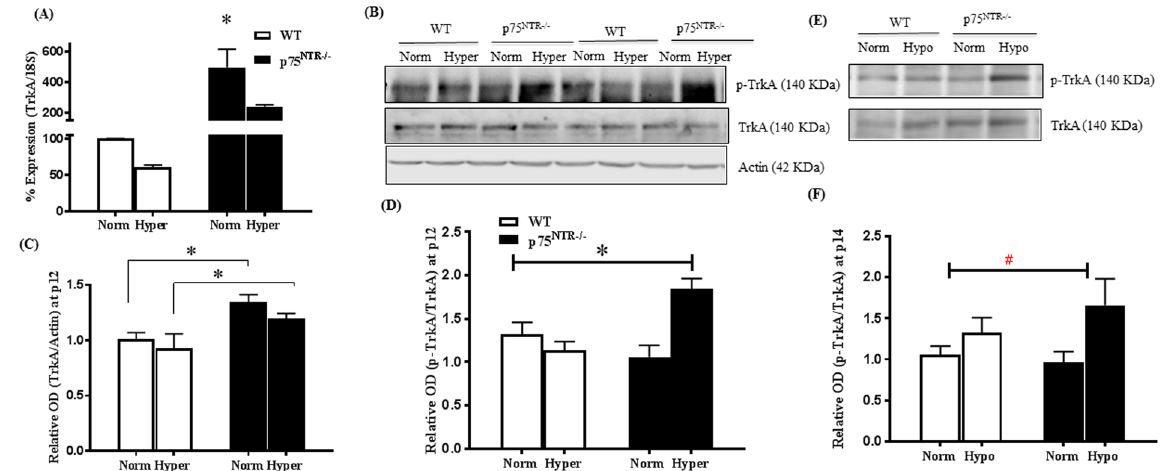
Figure 8. Deletion of p75 NTR enhanced expression and activation of NGF survival receptor; TrkA. ( A ) Quantitative real-time PCR of TrkA gene expression in p12 WT and p75 NTR − / − exposed to OIR showing significant increase in basal mRNA expression in p75 NTR − / − retinas compared to the other groups ( * significant using Two-Way ANOVA, p < 0.05, n = 6). ( B , C ) Representative Western blotting and bar graph statistical analysis of TrkA expression by p12 showing significant gene effect and significant increase in TrkA expression in p75 NTR − / − pups compared to their corresponding WT-controls under normoxia and hyperoxia ( * significant using Two-way ANOVA, p < 0.05, n = 6–9). ( B , D ) Representative Western blotting and bar graph statistical analysis of pTrkA activation by p12 showing an overall significant gene effect and a significant increase in pTrkA activation (Y490) in p75 NTR − / − pups exposed to hyperoxia compared to the rest of the groups ( * significant using Two-way ANOVA, p < 0.05, n = 6–9). ( E , F ) Representative Western blotting and bar graph statistical